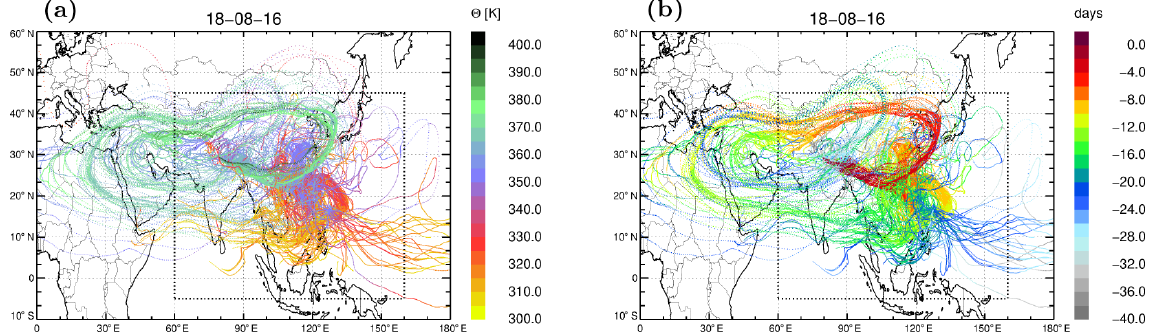
Figure 11. As Figs. 5 and 8 but for the balloon flight on 18 August 2016, heavily influenced by a typhoon in the western Pacific (Case